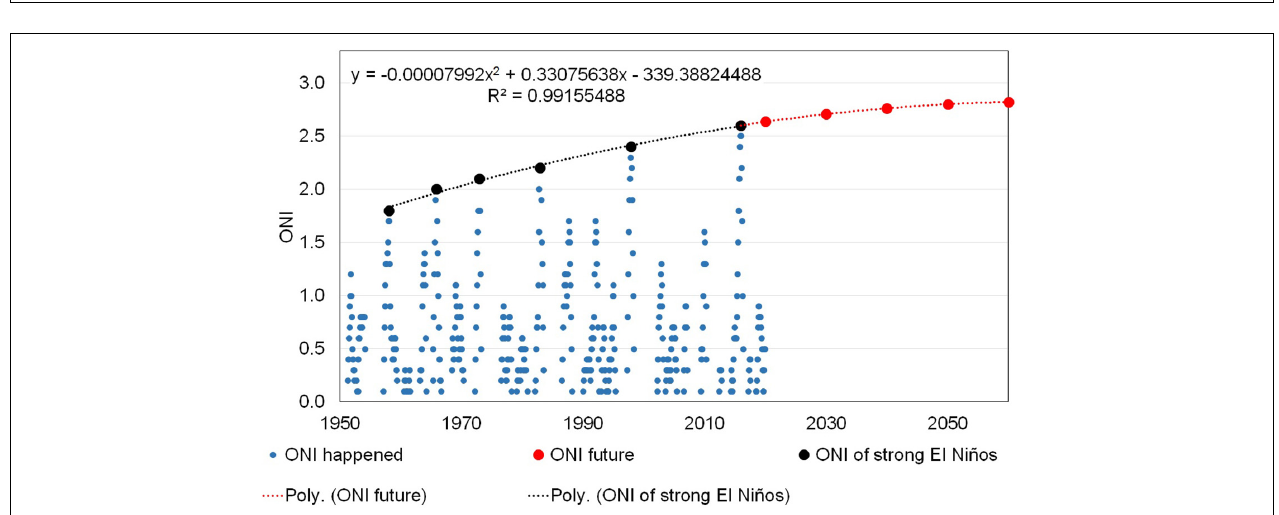
FIGURE 5 | Number of weeks having a temperature exceeding the ecological threshold of coral-31.5 ◦ C.